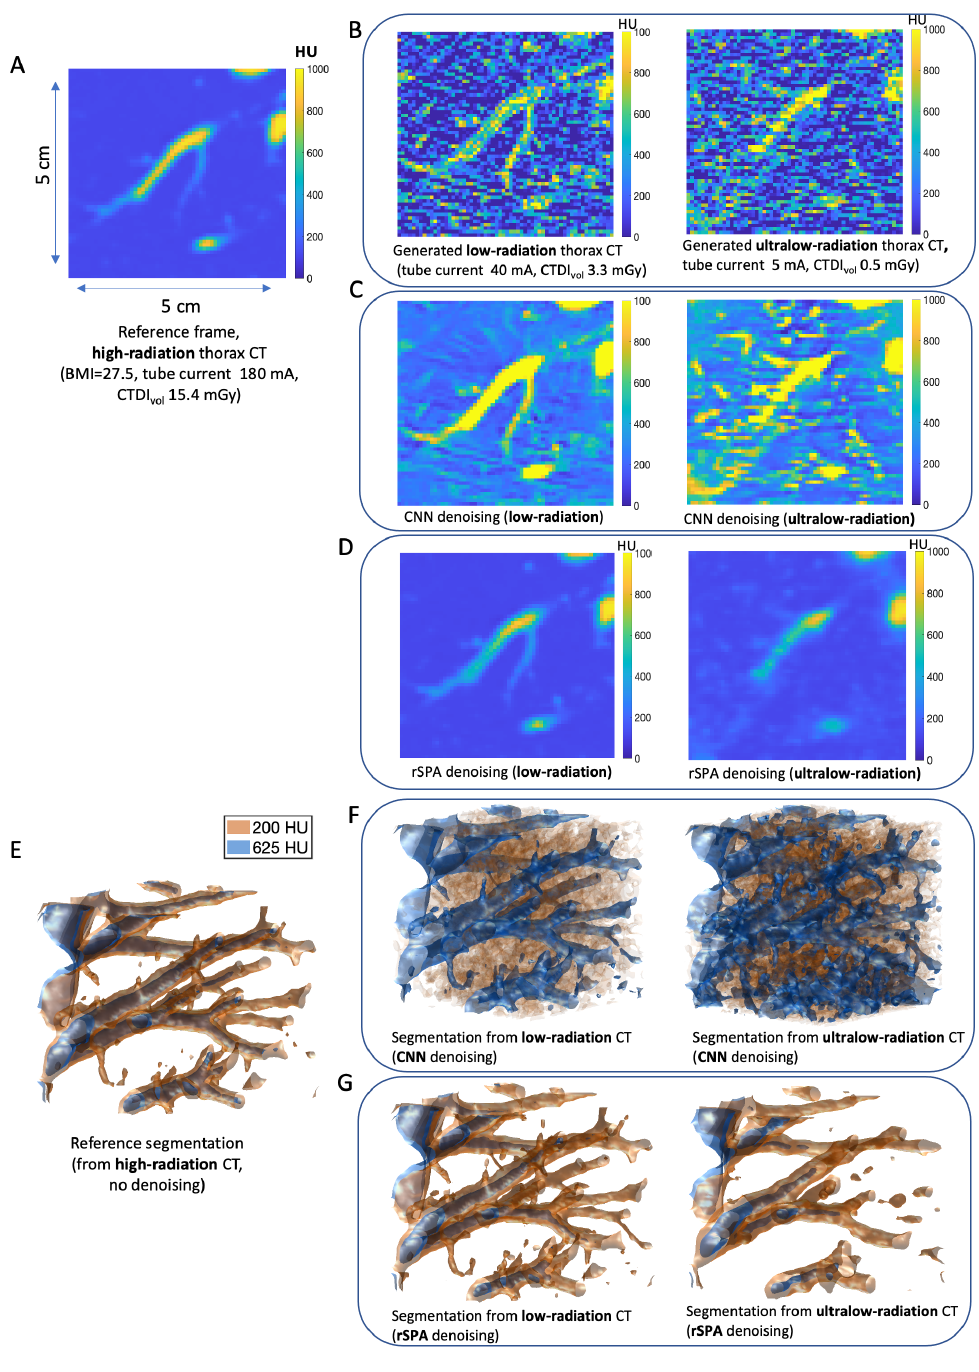
Figure 3. Radiation exposure, quantum noise, and denoising performance of CNNs and rSPA in low-radiation and ultra-low-radiation thorax CT regimes. ( A ) Reference data of a thorax CT voxel fragment (approx. 5 cm 3 ) of a 19-year-old female with the BMI 27.5, acquired with the Somatum Emotion 16 2007 (Siemens Aktiengesellschaft, Berlin, Germany) at 130 kV tube voltage. ( B ) Simulated decrease in the radiation exposure CTDI vol from 15.6 mGy (reference frame) to 3.3mGy (for low-radiation simulations) and 0.5 mGy (ultra-low-radiation) results in a significant increase of quantum noise. ( C ) Reconstructed images using CNNs. ( D ) Reconstructed images using rSPA. ( E ) 3D segmentation of the original reference frame. ( F ) 3D segmentation based on the images denoised using CNNs. ( G ) 3D-segmentation of the images denoised by